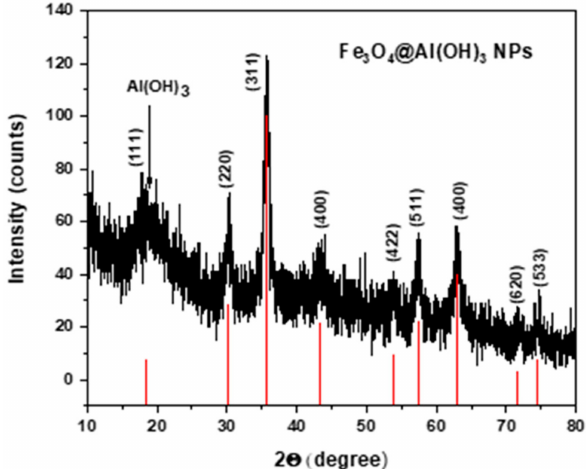
Figure 1. X-ray di ff raction (XRD) pattern of the core / shell structure of magnetite / aluminum hydroxide nanoparticles, compared to the XRD pattern of magnetite from the JCPDS 19-0629 data base.